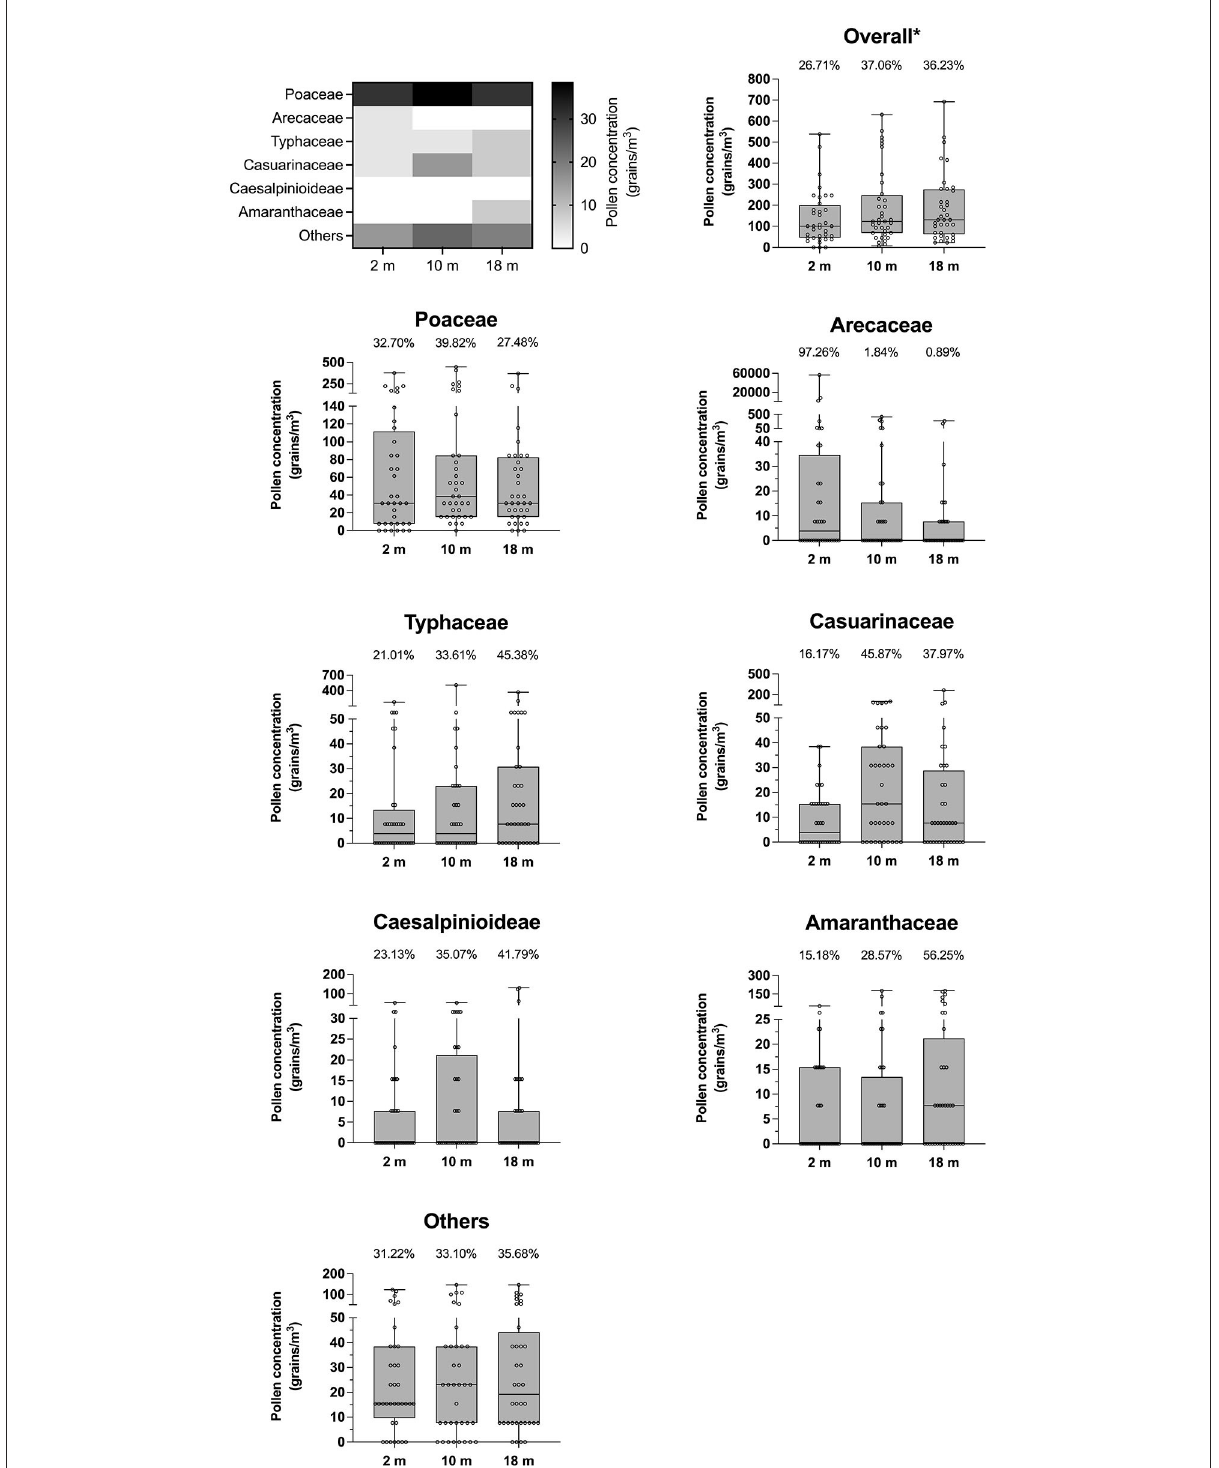
FIGURE4 Dynamics of pollen concentration in relation to height from ground. Heat map generated based on the median of each pollen species illustrates airborne pollen dynamics at different heights. Error bars of box plots represent median and interquartile range. A number above each bar represents the percentage of pollen concentration at each height divided by total pollen concentration of each pollen type. *Overall pollen counts excluded the amount of Arecaceae